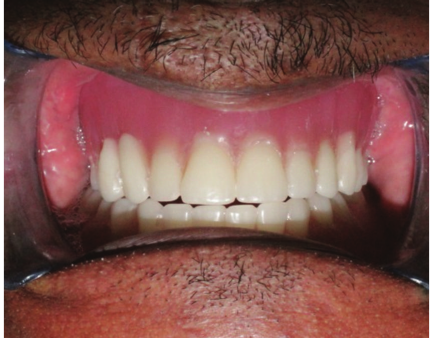
Figure 16: Fabricated